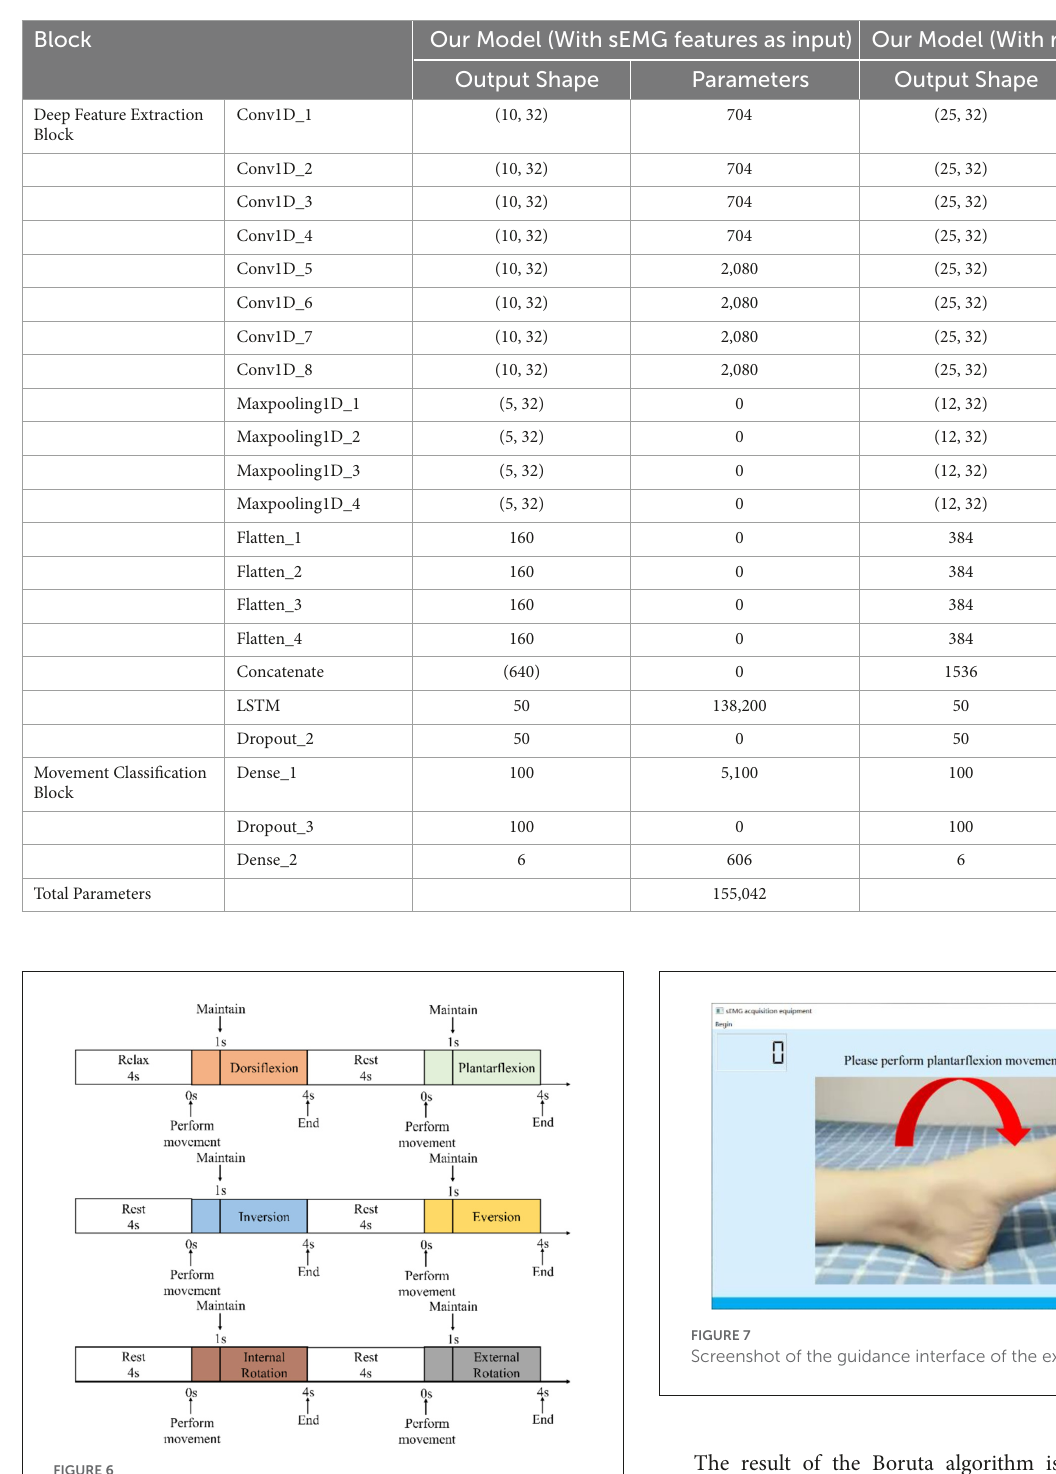
The result of the Boruta algorithm is shown in Figure 8 . The feature marked in blue is the shadow feature represented by Max_Shadow, Median_Shadow, Mean_Shadow, and Min_Shadow. The Z-Score of Max_Shadow was recorded as Z max , which was the criterion for judging the importance of features. Based on the Z-Score results, the feature suggested to be excluded was marked in red and seven features more related to ankle joint movements were marked in green. Therefore, seven features, including RMS, MAV, WL, ZC, SSC, VAR, and LogD, were selected to form